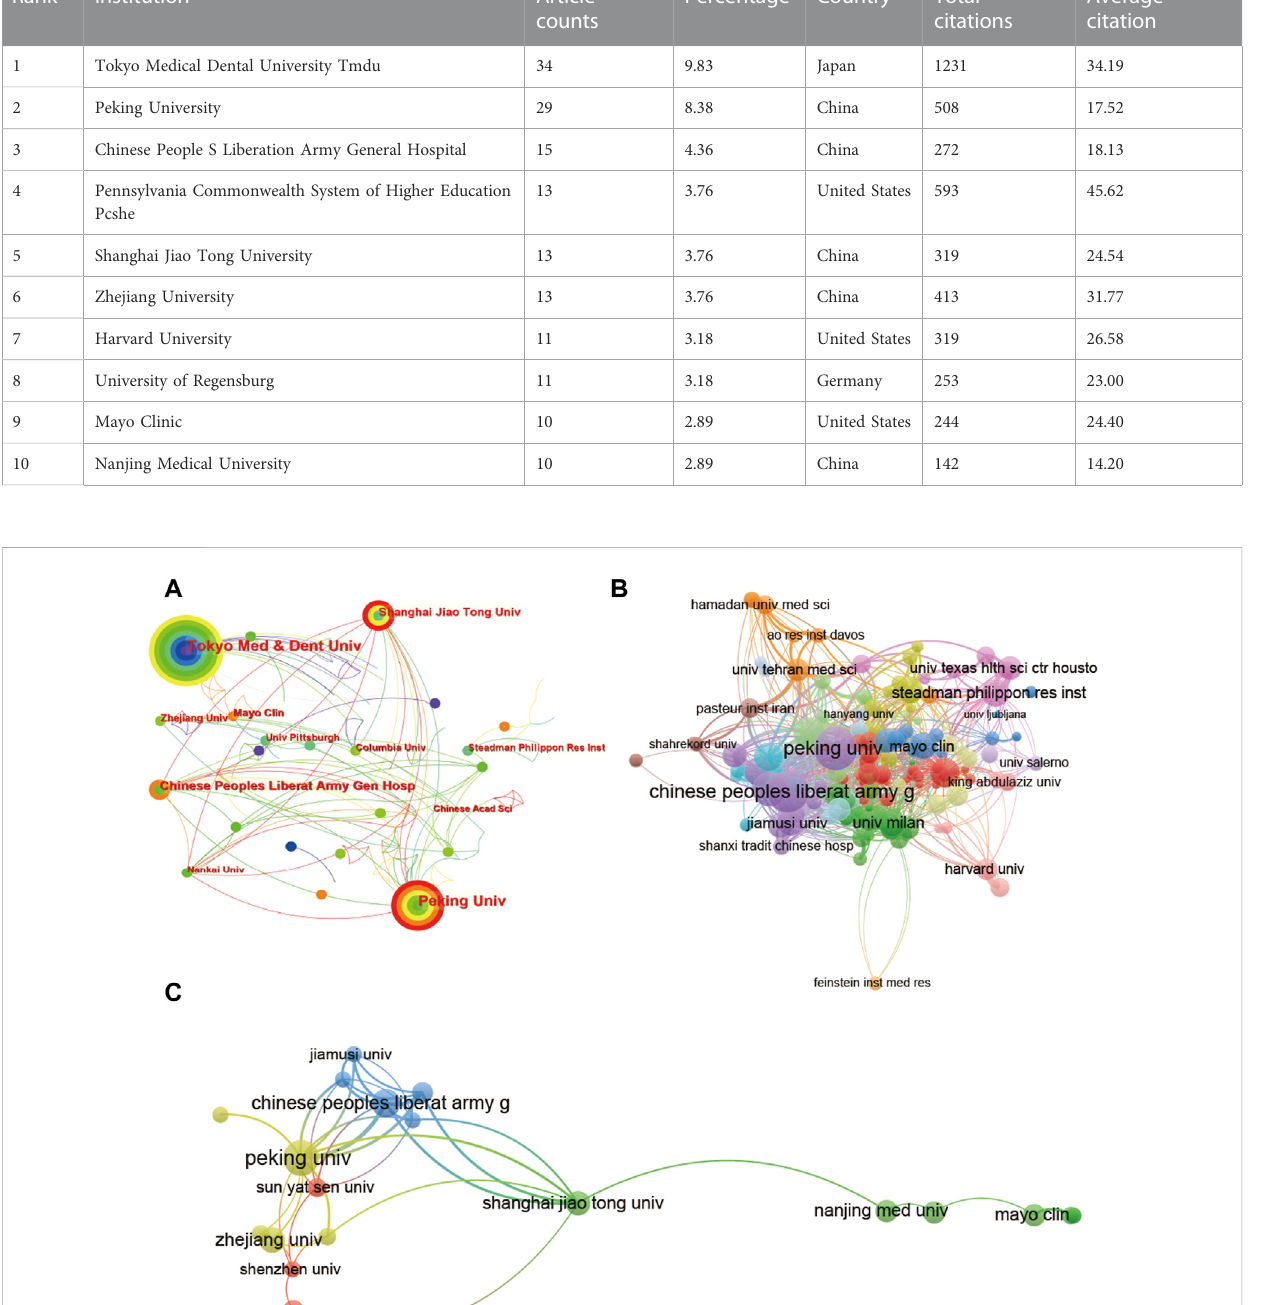
Figure 6C, a clear transition of collaboration with time from 2012 to